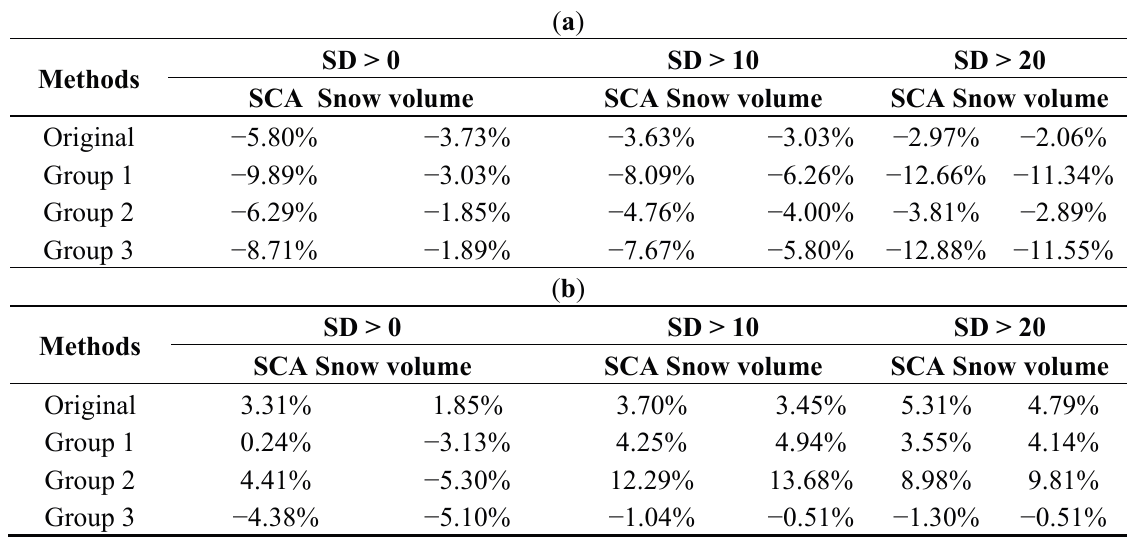
Table 5. Relative biases in the SCA and snow volume from overlapping sensors over China at different snow depth range ( a ) for F08/F11 and ( b ) for F11/F13. ( a